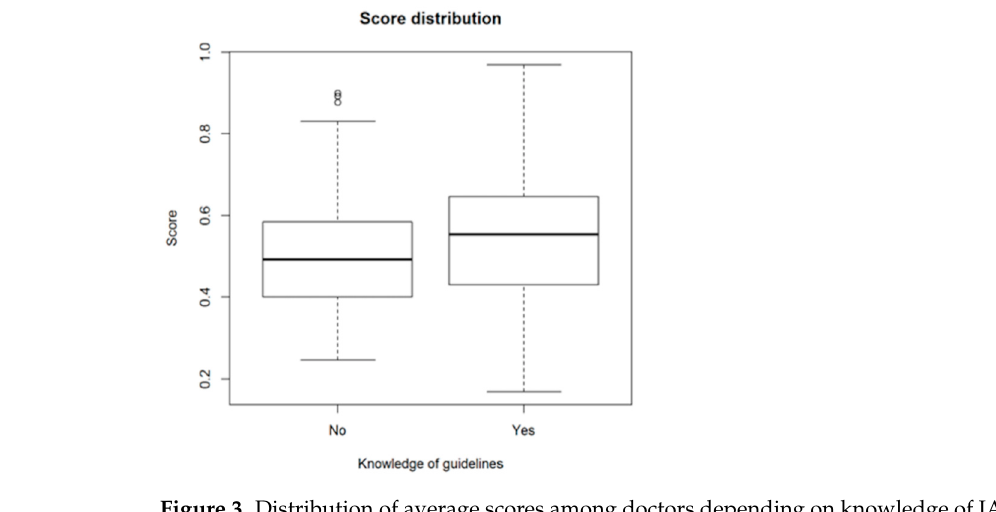
Figure 3. Distribution of average scores among doctors depending on knowledge of IADT guidelines declaration.